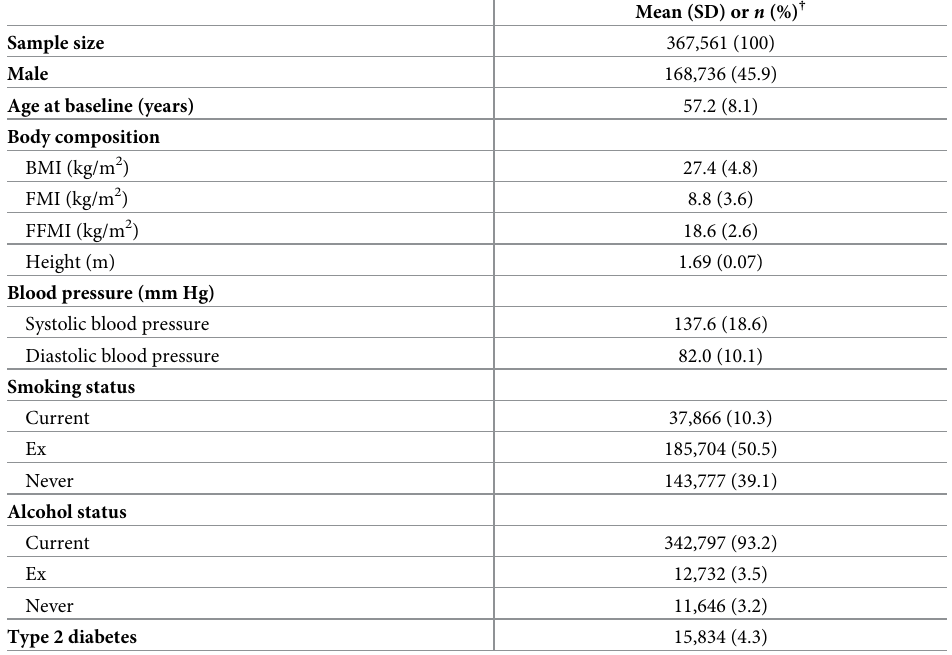
Table 1. Baseline characteristics of the UKBB participants included in this